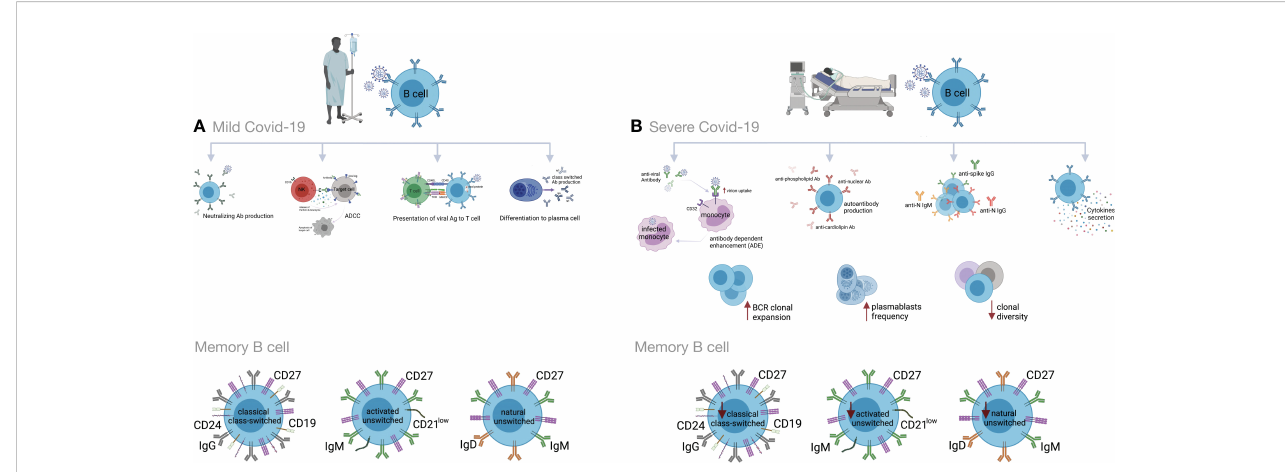
FIGURE 3 Humoral immune responses during COVID-19 progression in mild versus severe disease. (A) During mild COVID-19, B cells contribute to antiviral immune responses in many ways. The fi rst is through production of neutralizing antibodies (Abs), which will bind to the virion and block its entry to the host cells, thus impeding further infection. The second is through a process called antibody-dependent cellular cytotoxicity (ADCC), in which Fc receptor-bearing effector cells can recognize and kill antibody-coated target cells expressing pathogen-derived antigens. The third is through antigen presentation to T cells and activation of cell-mediated immunity. B cells also produce some cytokines to regulate in fl ammation and activation of adaptive responses. Lastly, B cells can differentiate into antibody-secreting plasma cells, which produce high af fi nity and class-switched Abs. (B) B cell immune responses in severe COVID-19 may exacerbate disease progression by excessive secretion of cytokines and production of autoantibodies. As an adverse effect anti-viral antibodies can facilitate the entry of virus into monocytes/macrophages and granulocytic cells through interaction with Fc and/ or complement receptors in a process that is called antibody dependent enhancement (ADE). In addition, increased clonal expansion of B cells, higher frequency of plasmablasts as well as reduced frequency of CD24 + switched and CD24 - CD27 + IgD + IgM + unswitched memory B cells have been reported in severe COVID-19 cases. Figure was created by BioRender (Toronto, ON,